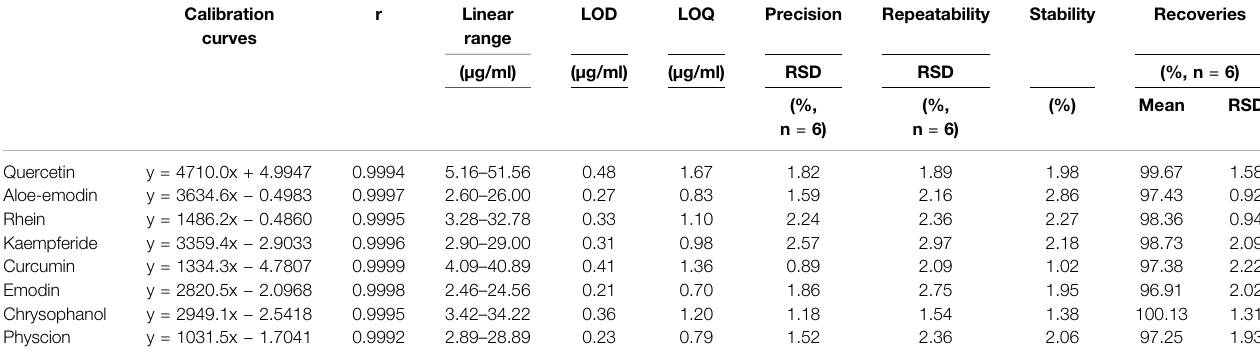
TABLE 3 | Calibration curves with r value, linear range, the limit of detection (LOD), limit of quantity value (LOQ), precision, reproducibility, stability, and recovery of the eight analytes. Calibration